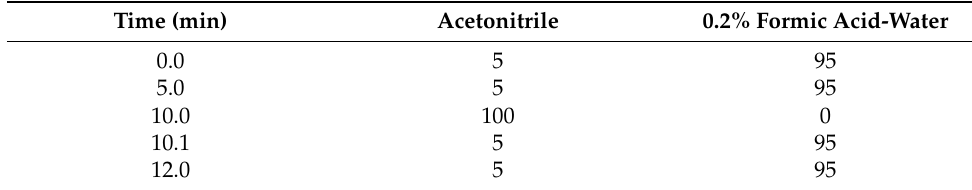
Table 10. Linear gradient elution procedure of sildenafil and N-desmethyl sildenafil. Time (min)